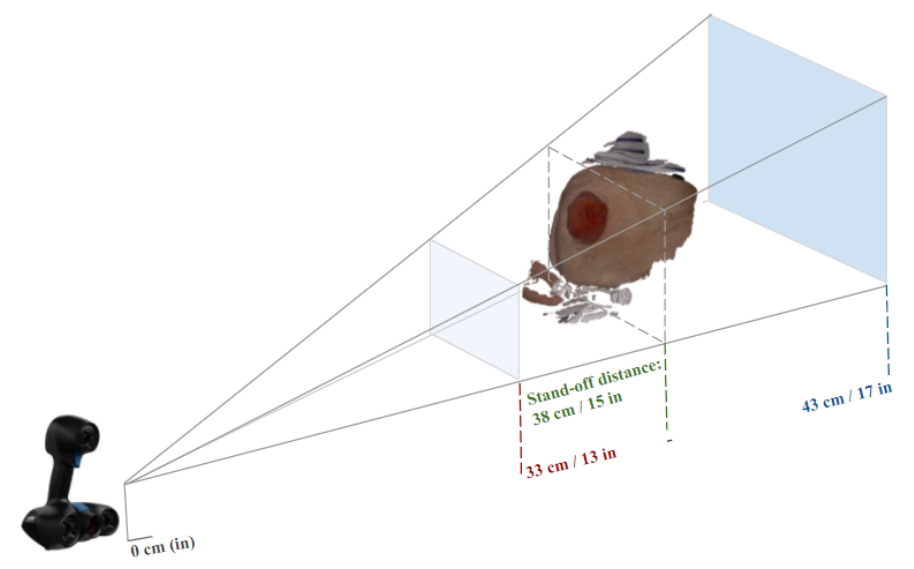
Figure 6. Illustration of the required distance to surface for the Go!scan 20.